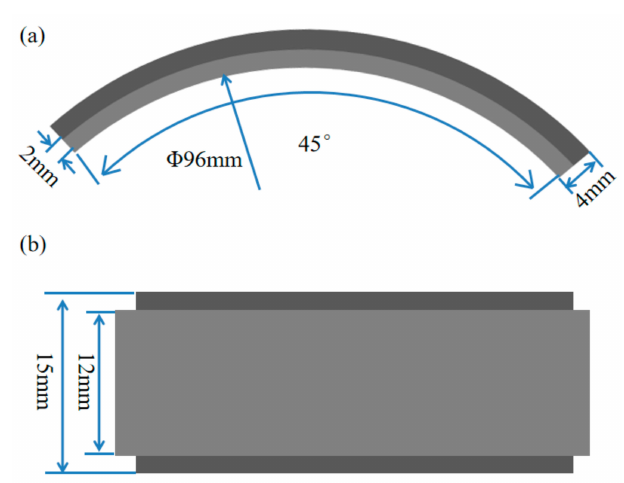
Figure 2. The shape and size of specimen ( a ) side view; ( b ) top